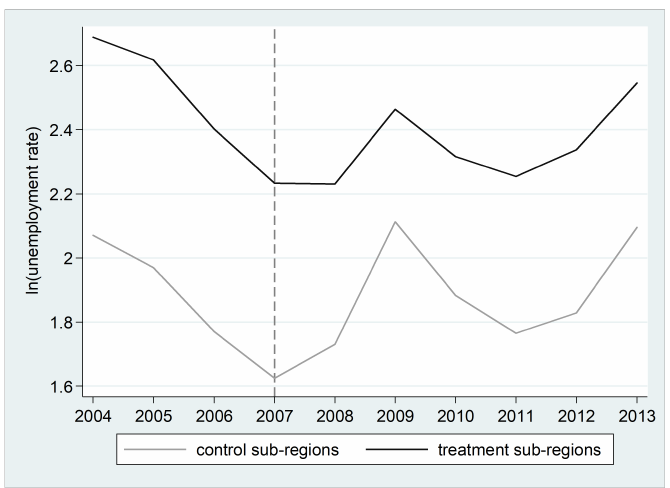
Figure 2: Mean of ln(unemployment rate) in the treatment and control sub-regions, previous transitional